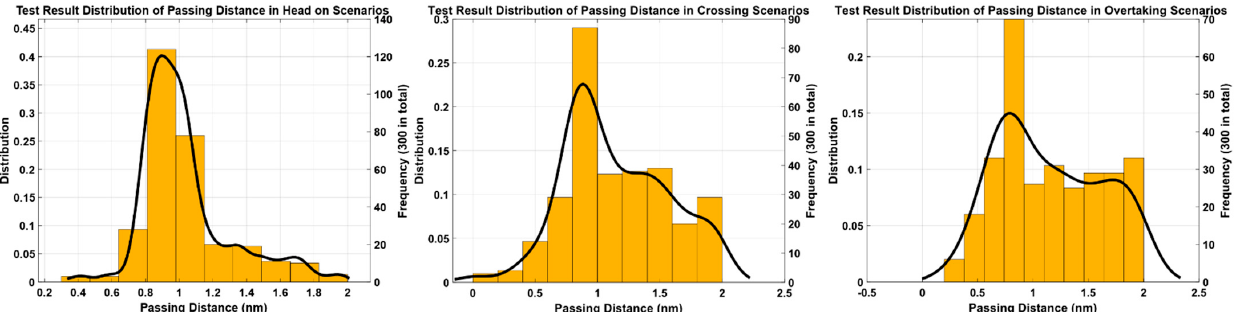
Figure 16. The distribution of passing distance by testing results.